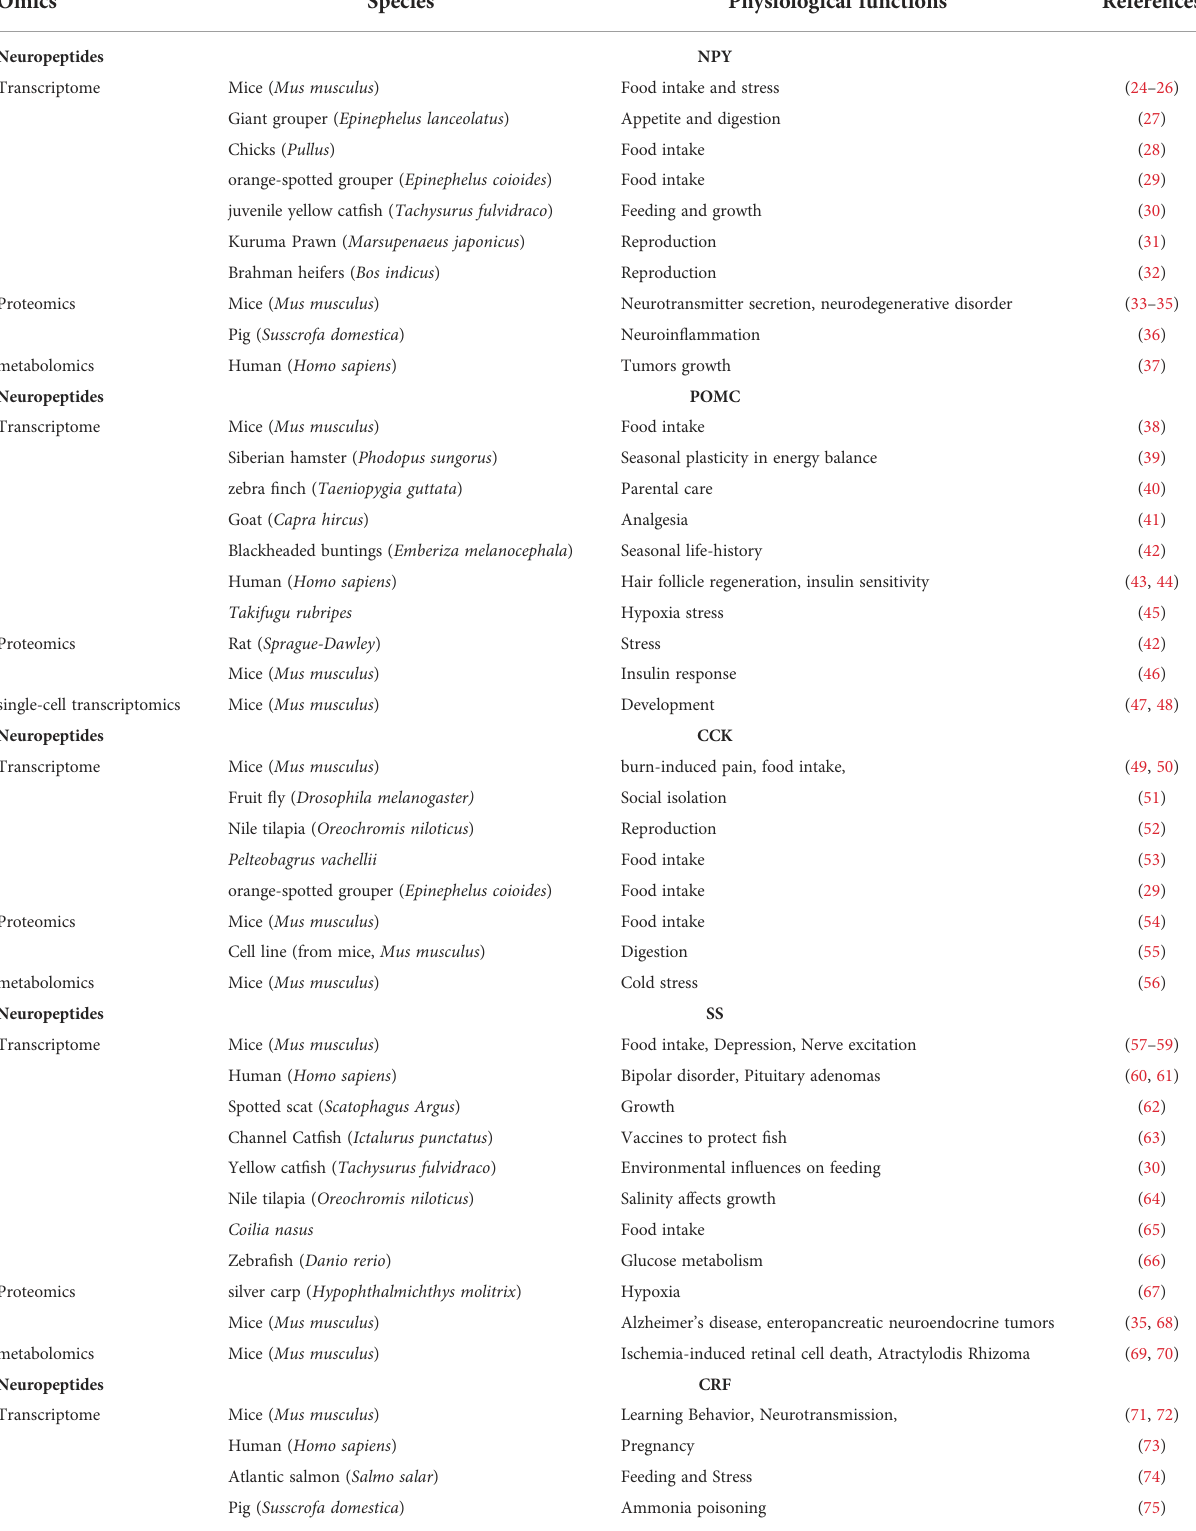
TABLE 1 Recent advances in the omics of neuropeptide and its receptors.